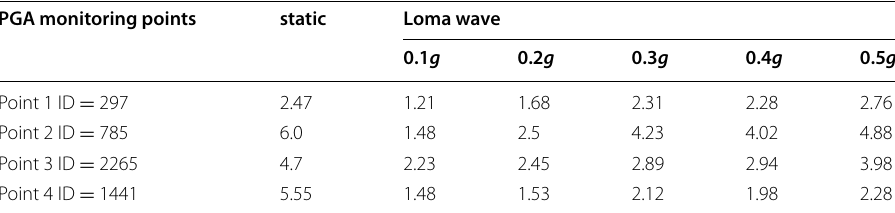
Table 2 Peak maximum principle stress of points 1–4 (10 5 Pa) PGA monitoring points